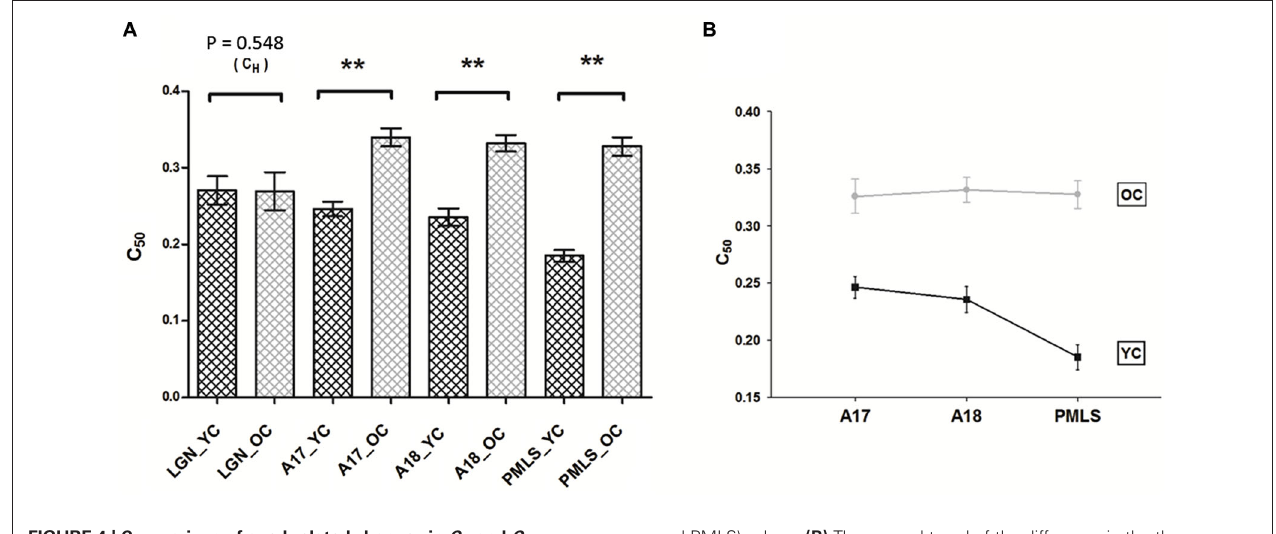
FIGURE 4 | Comparison of aged-related changes in C H and C 50 values between LGN, A17, A18, and PMLS . (A) Aging resulted in significant decline in C 50 values in three cortical areas, but not in LGN. Histograms indicate mean values of C H (LGN) and C 50 (for A17, A18,